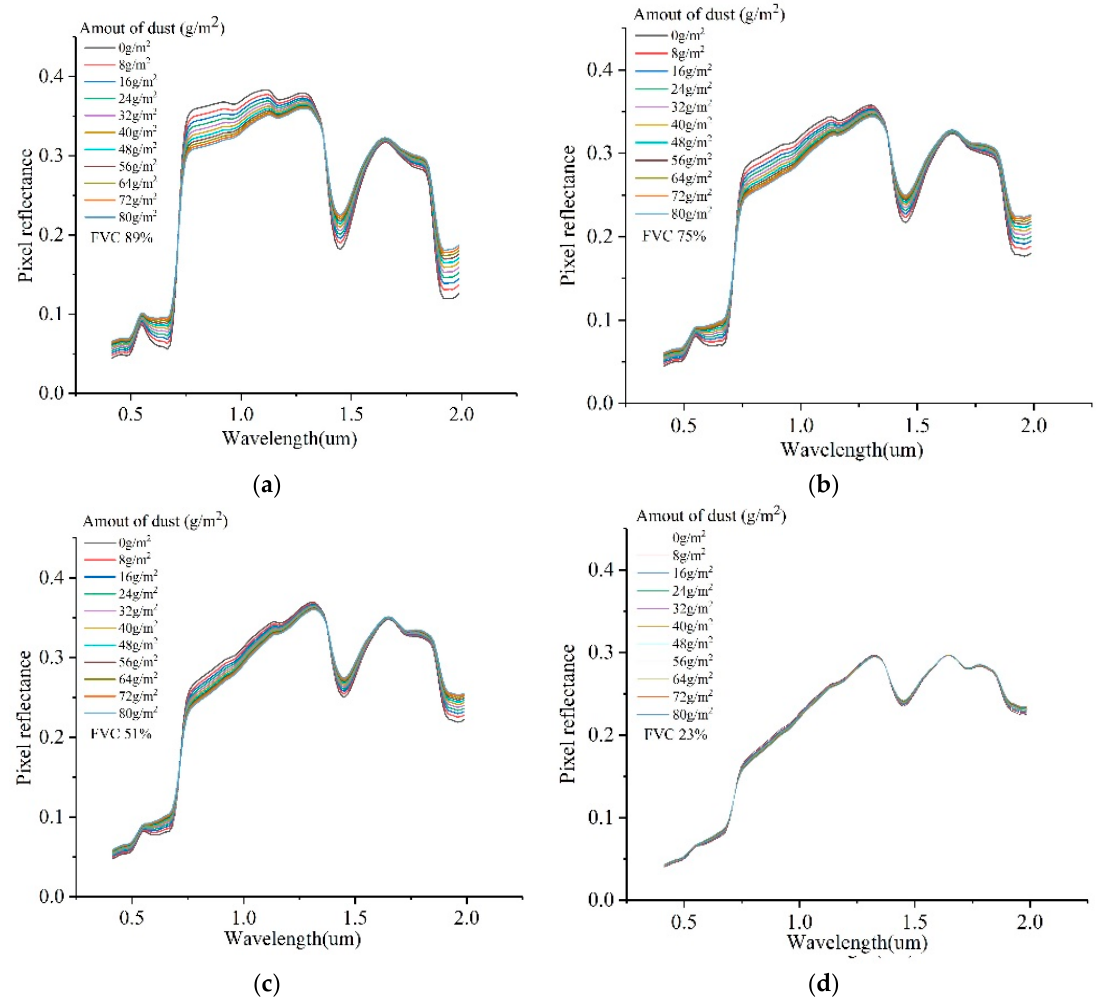
Figure 8. Effects of dust retention on vegetation spectra under different FVC conditions: ( a ) 89%, ( b ) 75%, ( c ) 51%, and ( d ) 23%.